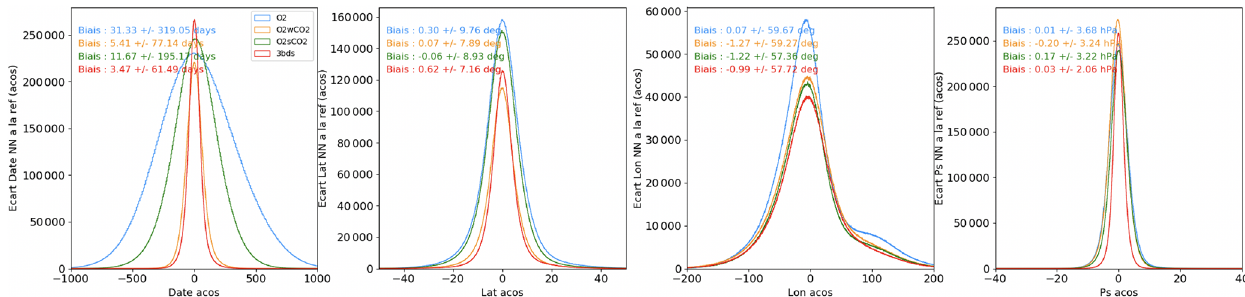
Figure 3. Analysis of the ability of the NN to estimate the date, location (latitude, longitude), and surface pressure from the input spectra and observation geometry. The graphs show the histograms of the differences between the NN estimate and the true value. Several versions of the NN were analyzed using all three bands (red), only the wCO2 and O 2 bands (orange), sCO2 and O 2 (green), and only the O 2 band